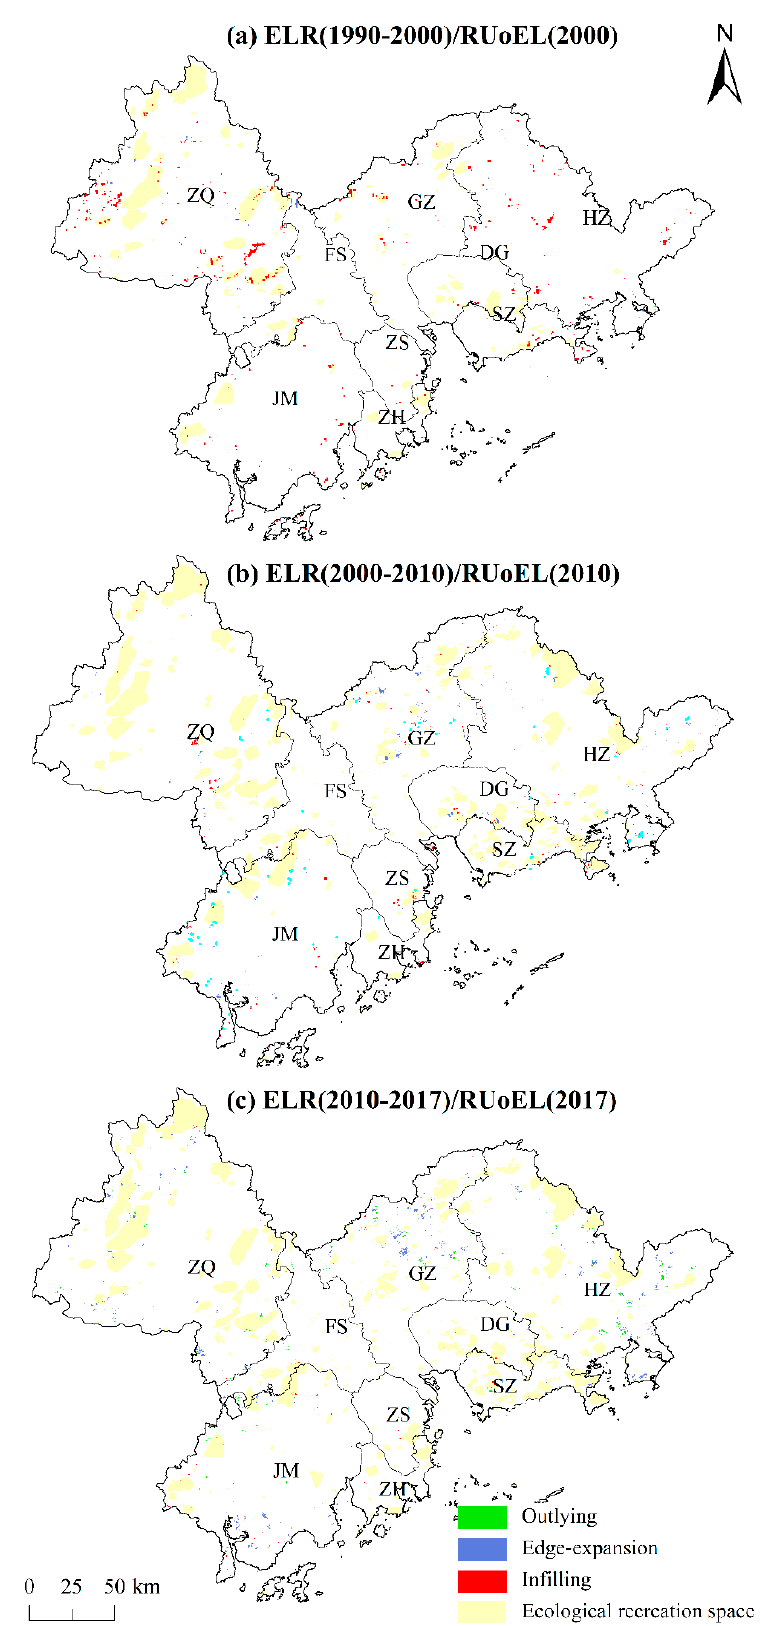
Figure 6. Spatial relationship between the ecological land restoration (ELR) patches and the recrea- tional use of ecological land (RUoEL).